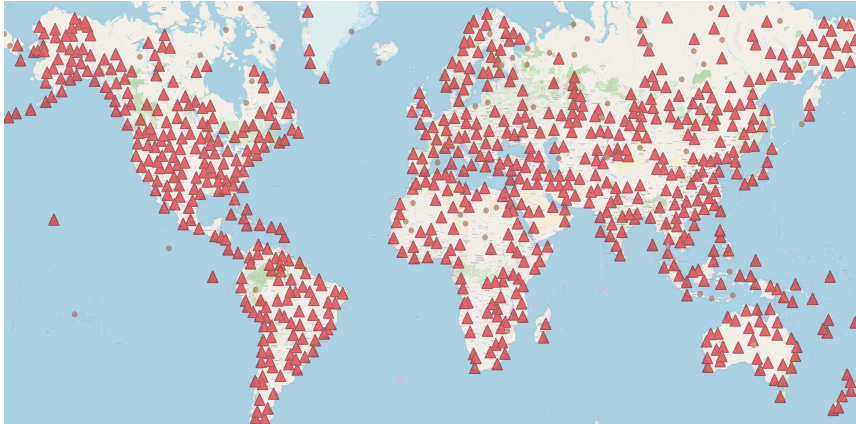
Figure 8. Weighted overlay analysis of the Mineral Resources Data System (MRDS) dataset over Open Street Map without labels.